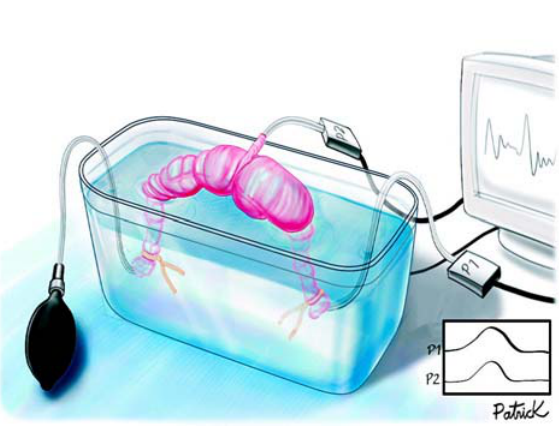
Figure 4 – Illustrative photo of the experiment showing arrangement of catheters and P1 and P2 transducers for demonstrating before immersion on the water and give the